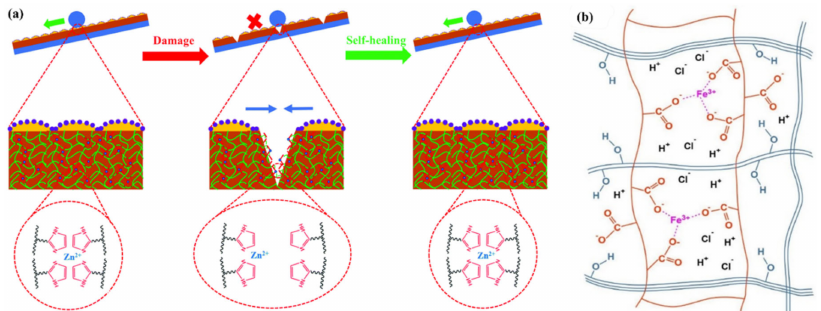
Figure 21. ( a ) Elastomer self-healing through bond reforming. Reproduced from [152] with permission from The Royal Society of Chemistry. ( b ) Completed molecular structures of Fe 3 + / PAA-PVA hydrogels. Reproduced from [153] with permission from Elsevier.